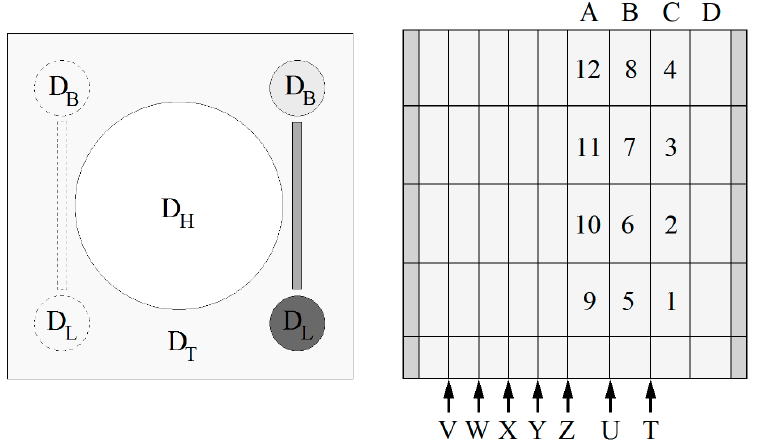
Figure 3. Schematic of the ( left ) beam purity indicator and ( right ) sensitivity indicator showing shims A–D, gaps T–Z and holes 1–12.